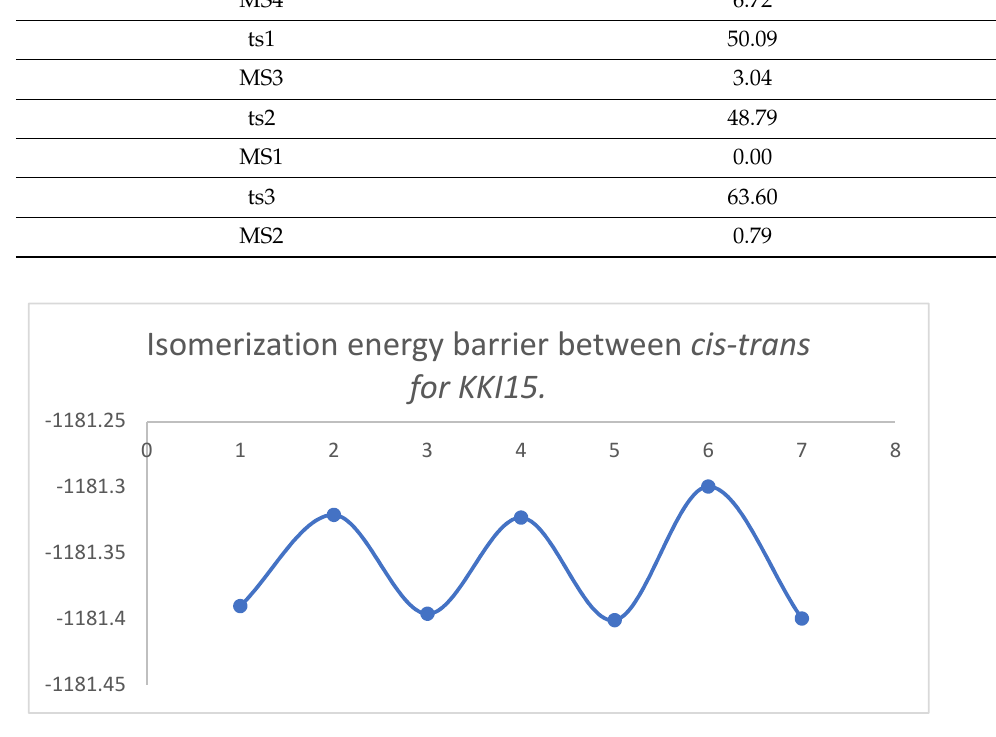
Figure 8. Schematic representation of the isomerization energy barrier between cis - trans (y = Energy in Hartree, x = conformation).